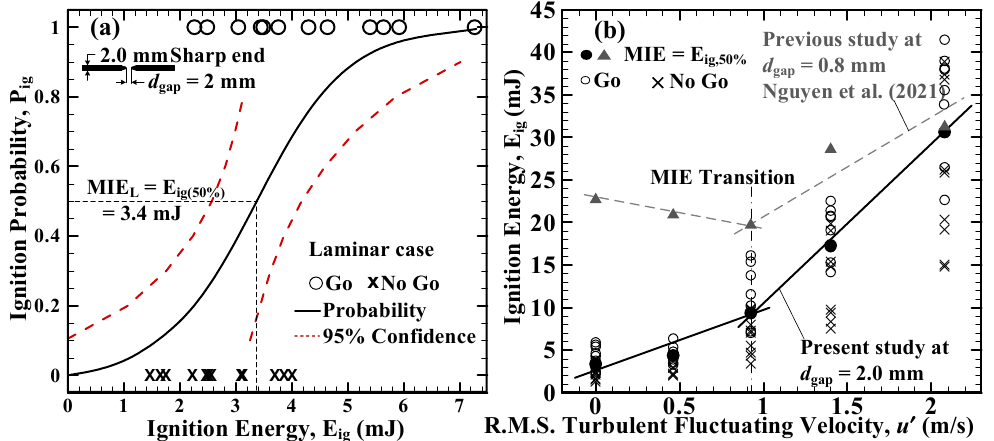
Figure 2. ( a ) A typical example for determining MIE at 50% ignitability (=E ig,50% ) using the logistic regression method. ( b ) The present MIE T data as a function of u ′ , showing a regular MIE transition occurring at a critical u ′ c ≈ 0.92 m/s. In addition, also plotted for comparison are previous data measured at small d gap = 0.8 mm for the same lean n-butane/air mixture, revealing an irregular MIE transition with TFI when u ′ < u ′ c ≈ 0.92 m/s [24].